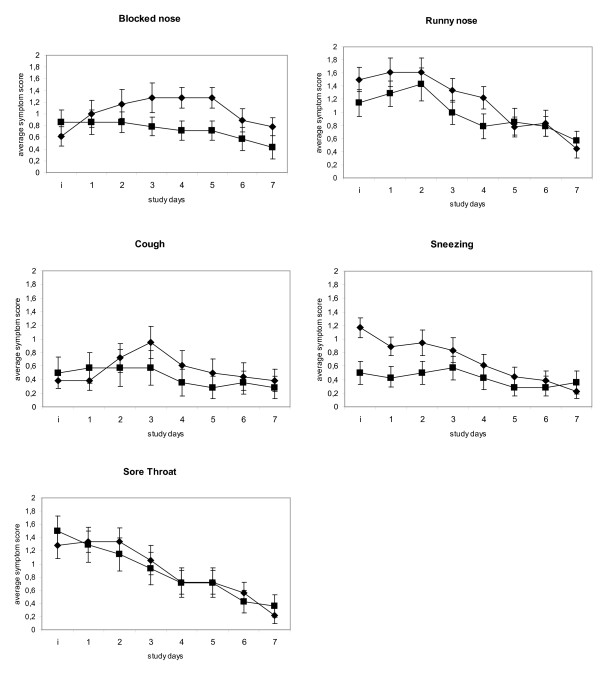
Mean individual symptom scores over 7 days. Mean individual symptom scores ± SEM for Carrageenan nasal spray (black squares) and Placebo (black triangles) treatment groups. The y axis shows the day of recording. The y axis shows the study day; i indicates the point of inclusion into the study.